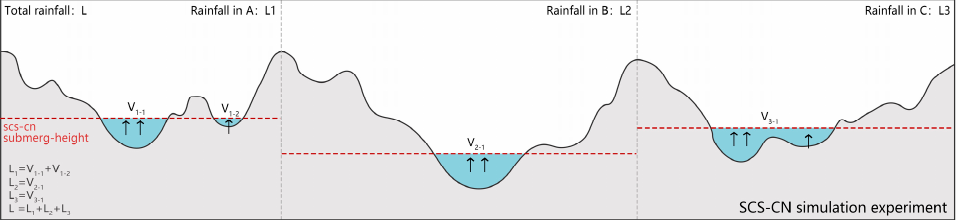
Figure 1. SCS-CN-based flood-submerging simulation experiment.